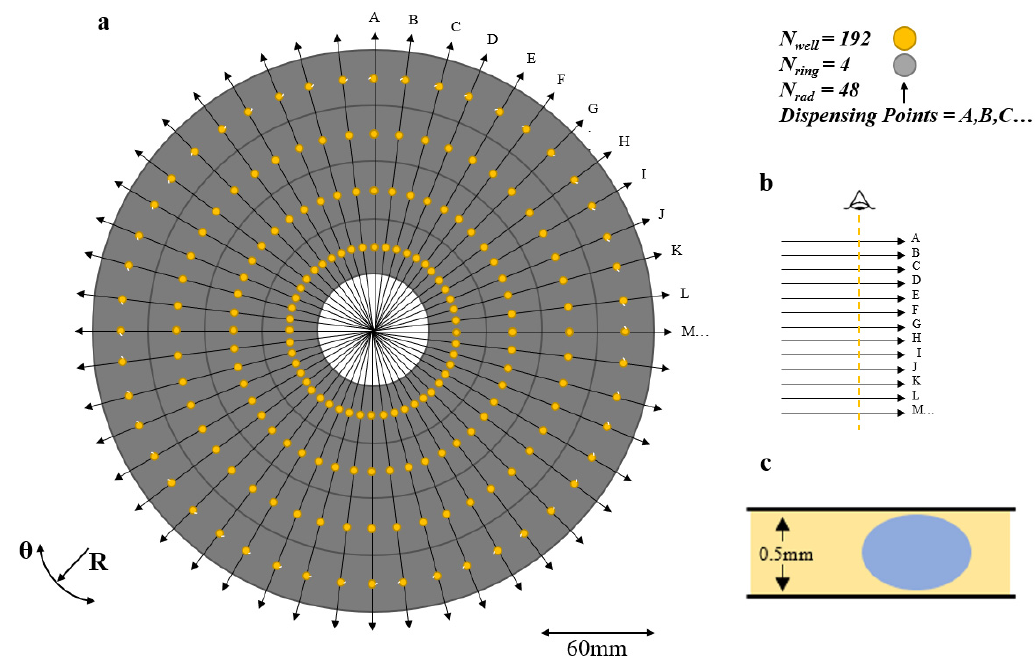
Figure 7. Proposed Commercial 48 × 4 Configuration. ( a ) 48 × 4 system containing forty-eight drugs in four different dilutions. Each radius of the system contains a single drug, with each ring in that radius containing a dilution of that drug. Each dot represents a well containing a drug dilution. Any number of radii and rings may be utilised depending on the needs of the user. At maximum some produces 53 million combinations of four. ( b ) After exiting the rotors, the droplets are read using either fiber optics or laser LEDs. ( c ) Typical droplet completely surrounded by silicone oil.